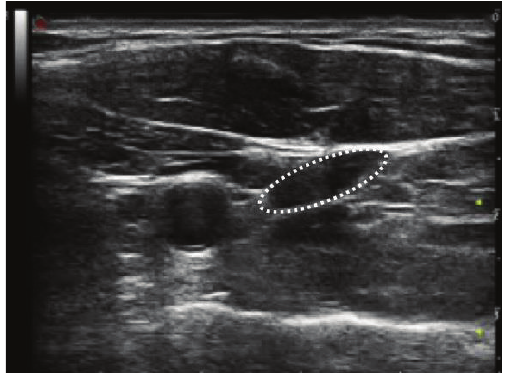
Figure 2: High resolution B-mode ultrasound imaging of the same case, in the transversal access of the neck, shows the elliptical shape of the internal jugular vein, outlined by the interrupted line.